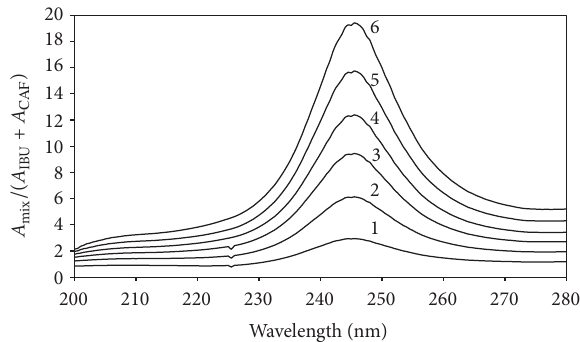
F 3: Double divisor of the ratio spectra for a ternary mixture of aspirin, caffeine, and paracetamol aer simultaneous standard addition of three components in the concentration range